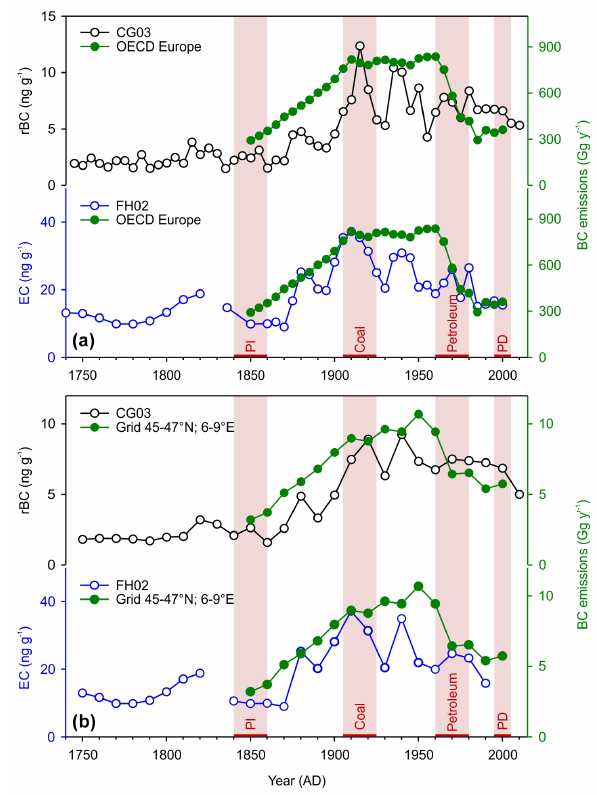
Figure 6. (a) CG03 rBC and FH02 EC concentrations and energy- consumption based BC emission estimates from fossil fuel and bio- fuel burning (Bond et al., 2007) for OECD Europe and (b) for the grid cells 45–47 ◦ N and 6–9 ◦ E encompassing the locations of the ice-core drilling sites and the four glacier observation records in the Western Alps (see Fig. 1). Mean rBC no BB concentrations and relative enrichment to pre-industrial (PI) are provided for specific age windows marked by red shading (summarized in Table 3) dom- inated by coal-burning, petroleum-product burning and present day (PD)